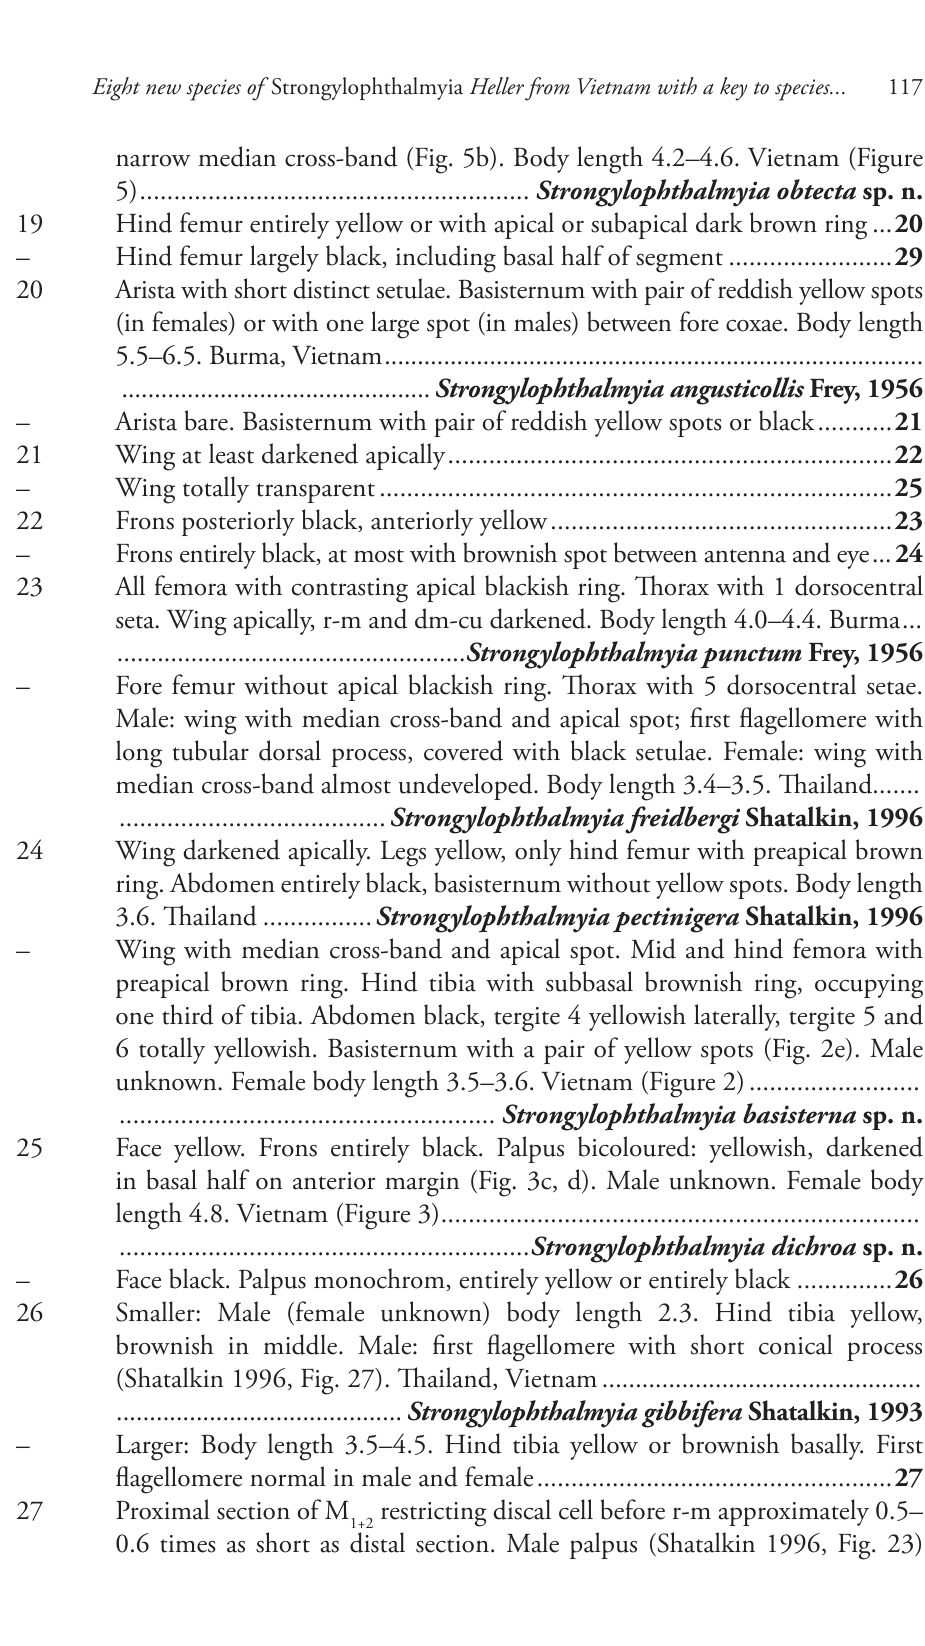
narrow median cross-band (Fig. 5b). Body length 4.2–4.6. Vietnam (Figure 19 Hind femur entirely yellow or with apical or subapical dark brown ring ... 20 – Hind femur largely black, including basal half of segment ........................ 29 20 Arista with short distinct setulae. Basisternum with pair of reddish yellow spots (in females) or with one large spot (in males) between fore coxae. Body length